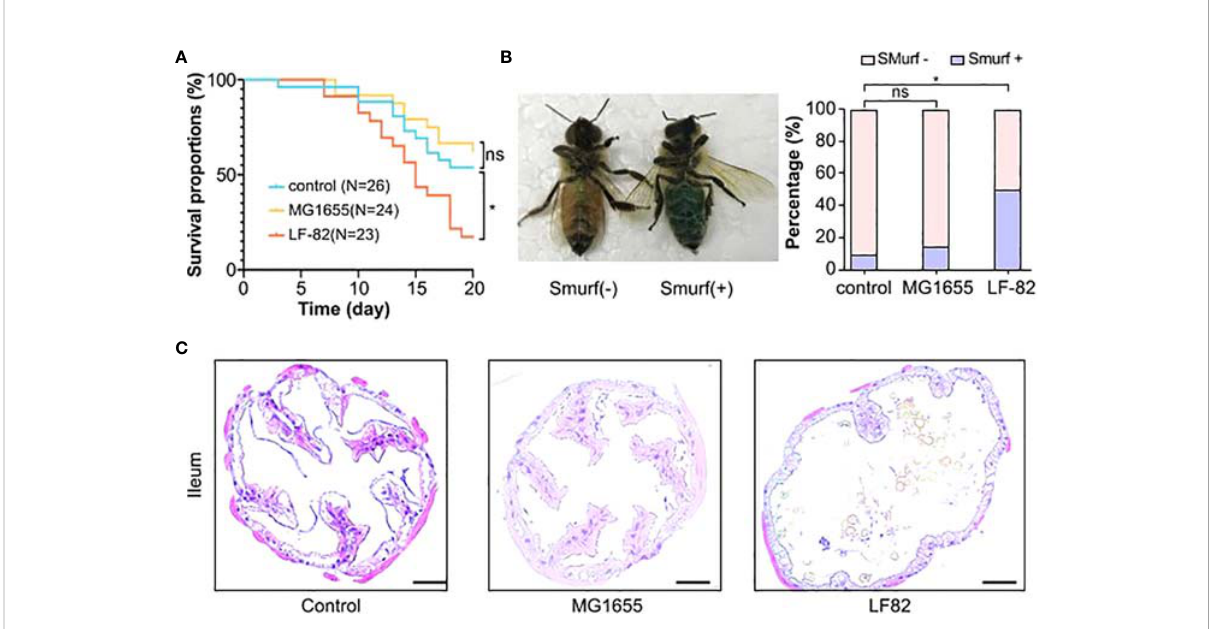
FIGURE 2 LF82 impacts the gut and decreases the lifespan of the honeybee. (A) The Kaplan – Meier survival curves of honeybees in different groups (* p < 0.05; ns, not statistically signi fi cant). (B) Positive and negative honeybees in the Smurf experiment and the proportion in each group (* p < 0.05). (C) Histopathologic evaluation with hematoxylin and eosin staining shows structural disruption in the epithelium of illem of the LF82 group (Bars = 50 m